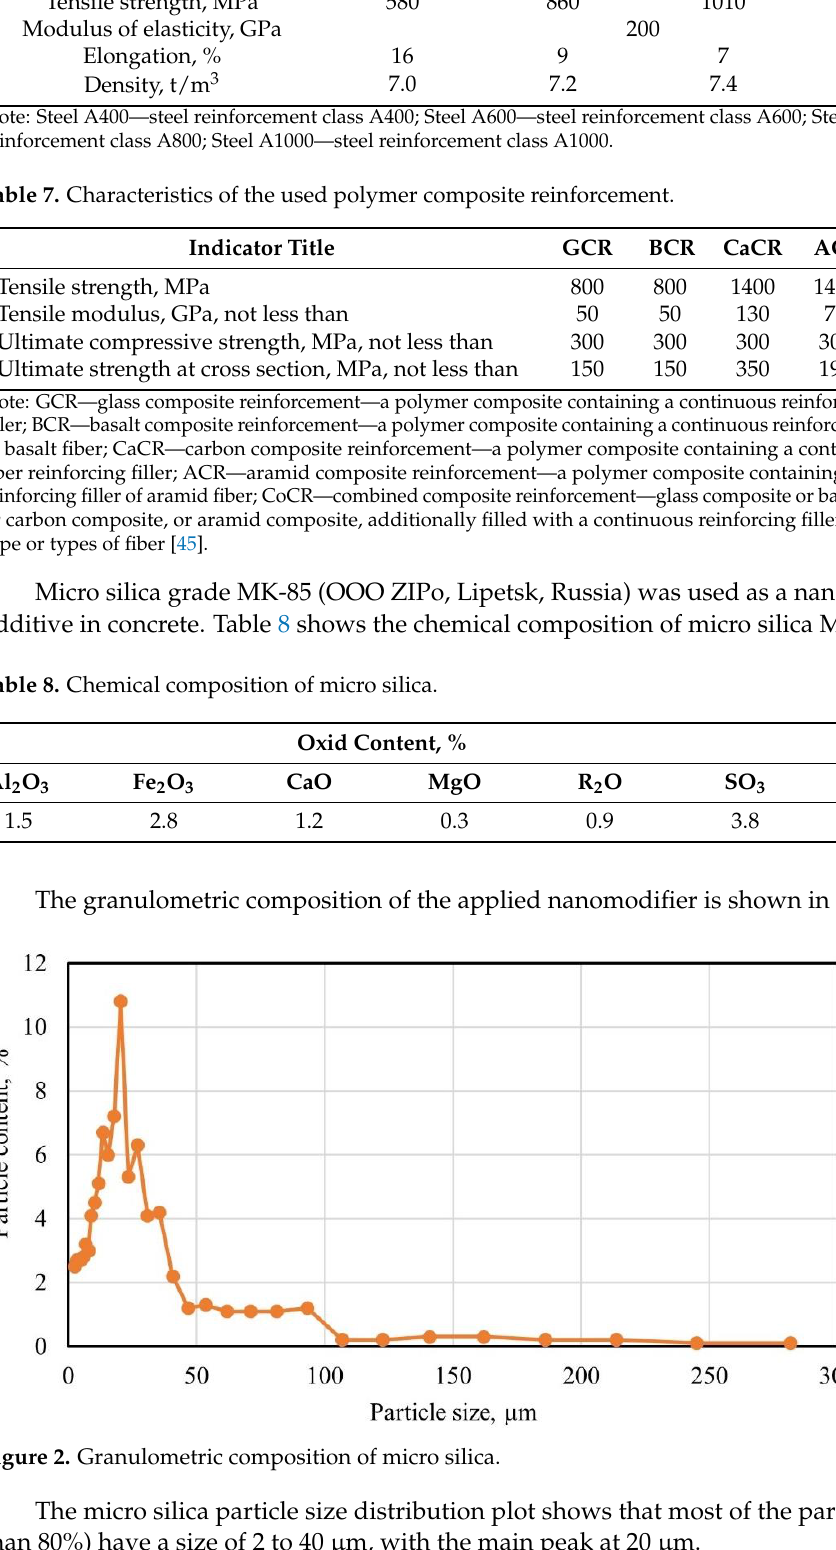
Figure 3. Micro silica diffraction pattern. Micro silica (Figure 2) is represented by amorphous silica, minor impurities of iron, carbonaceous substances, and crystalline α -quartz. Lightweight fiber-reinforced concrete was also studied in accordance with [46 – 50]. Glass fiber (Armplast, Nizhny Novgorod, Russia) was used as dispersed reinforcing fi- bers, the physical and mechanical characteristics of which are presented in Table 9. Slag pumice (Stroymir LLC, Lipetsk, Russia) was used as a filler, the physical and mechanical characteristics of which are presented in Table 10. The mineralogical composition of slag pumice is characterized by light minerals (80%), which include calcium and magnesium